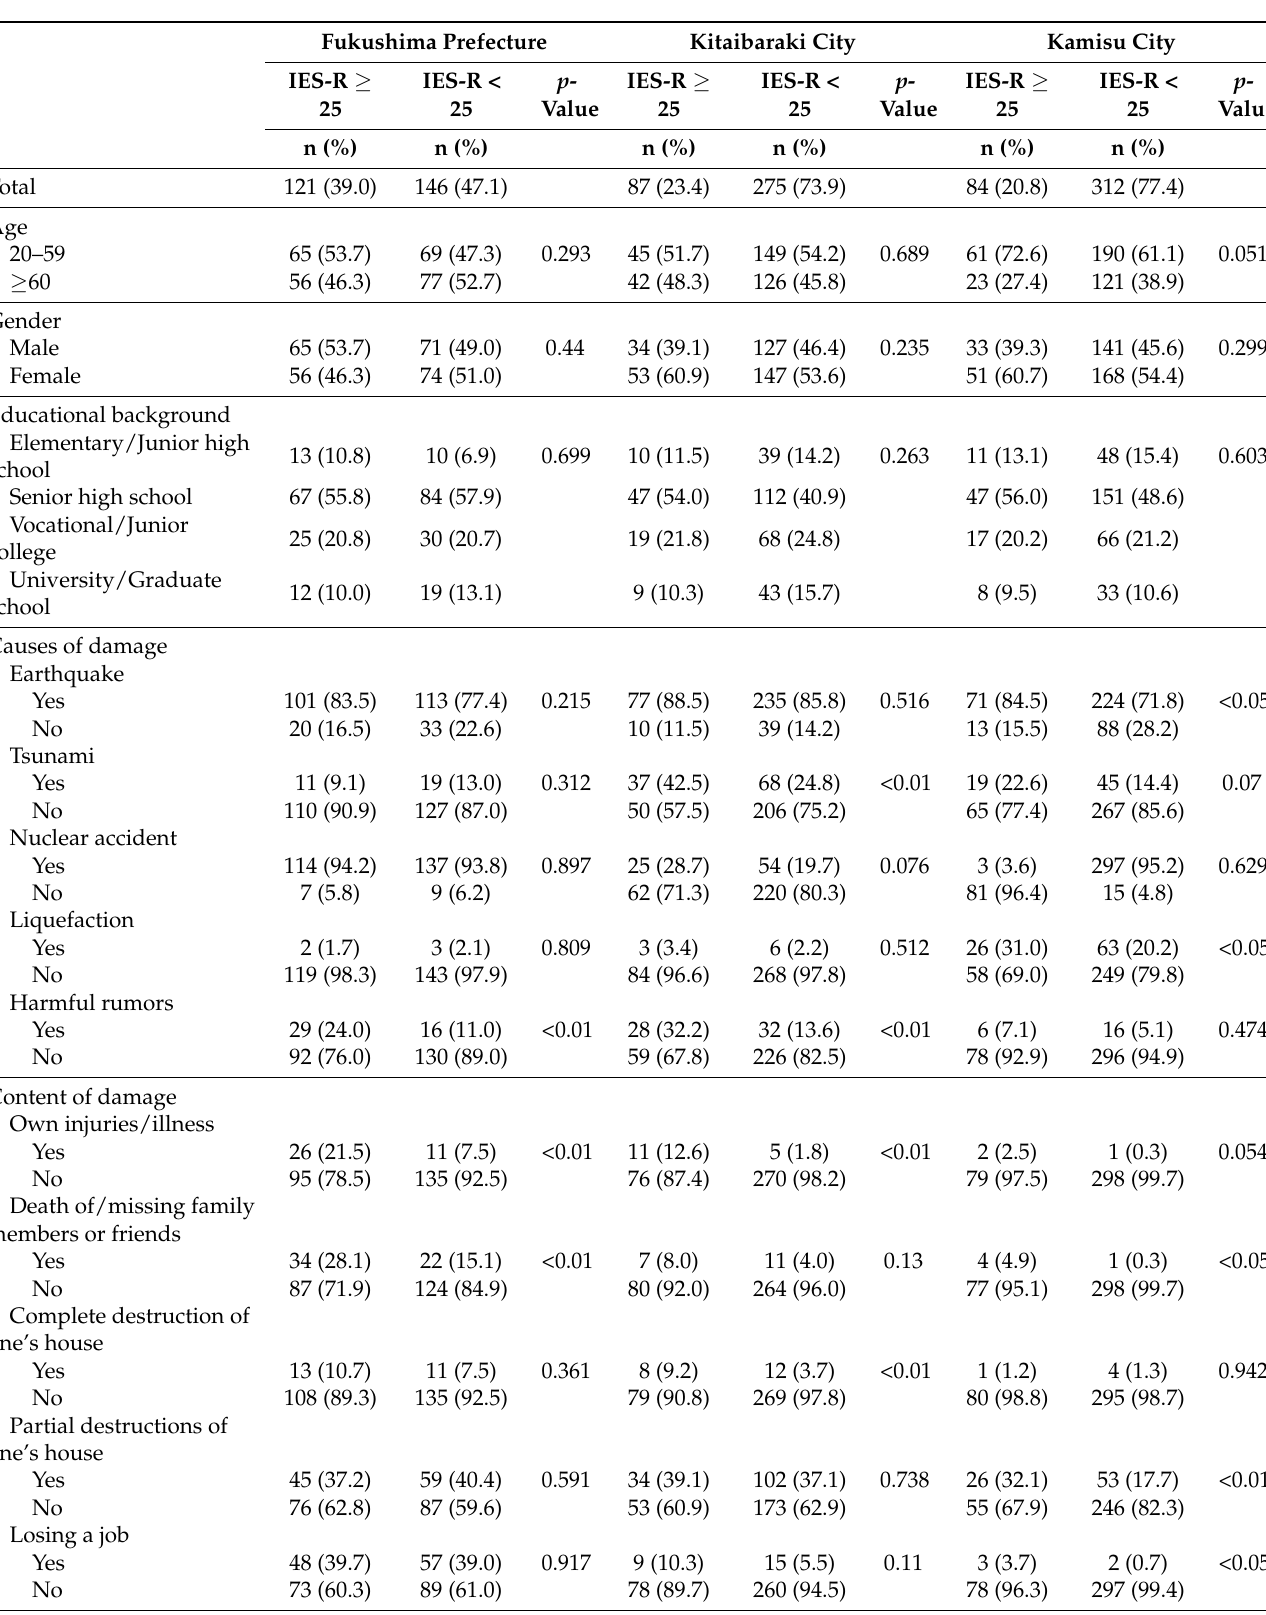
Table 3. The Impact of Events Scale-Revised (IES-R) of three regional groups depending on the participants’ attributes and damage